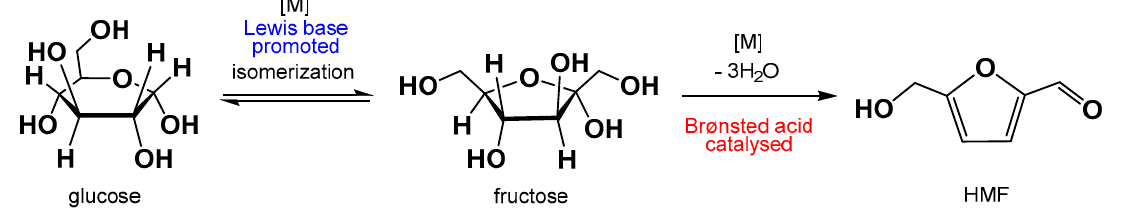
Figure 2. Transformation of glucose to 5-hydroxymethylfurfural (HMF) via fructose.